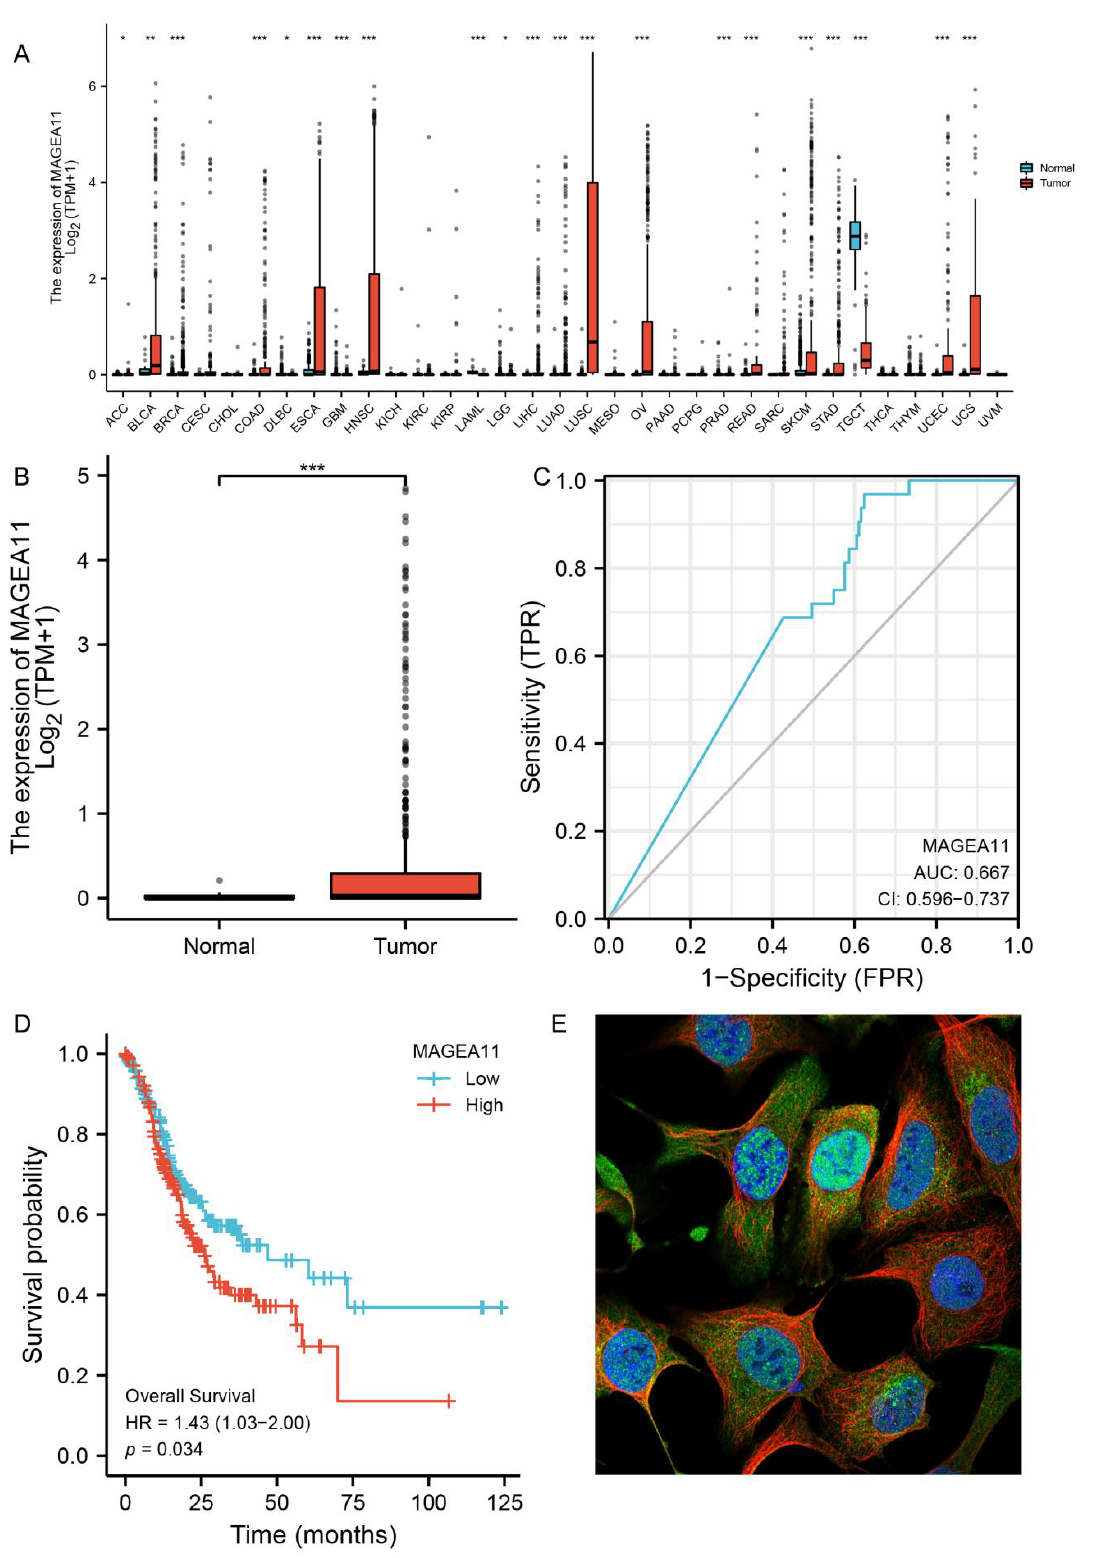
Figure 1. MAGEA11 expression and prognosis. ( A ) Expression of MAGEA11 in pan-cancer. ( B ) MAGEA11 mRNA expression in gastric cancer and normal tissues. ( C ) ROC curve. ( D ) Kaplan– Meier survival curve. ( E ) The subcellular distribution of MAGEA11 . Green is the target protein staining, red is microtubules staining, and blue is nucleus staining. (* p < 0.05, ** p < 0.01, and *** p <